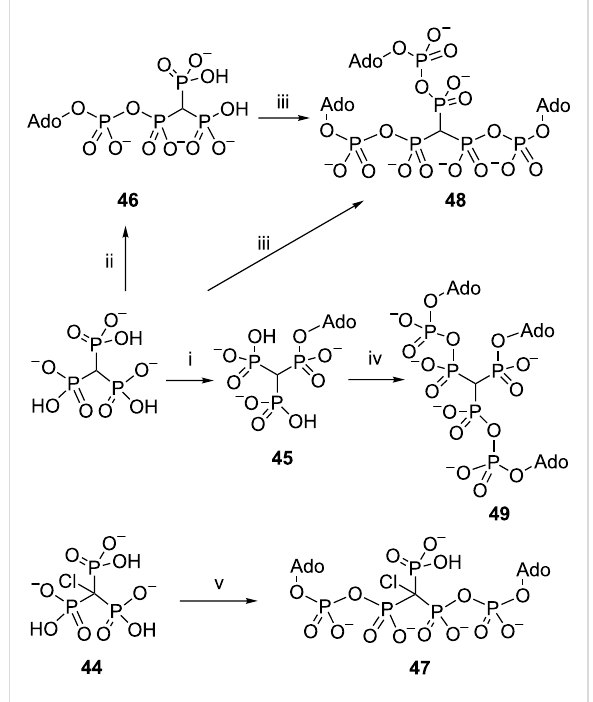
Figure 1: Bond angles and bond distances in pyrophosphate, methylene-1,1-bisphosphonate and fluoromethylidynetrisphosphonate.